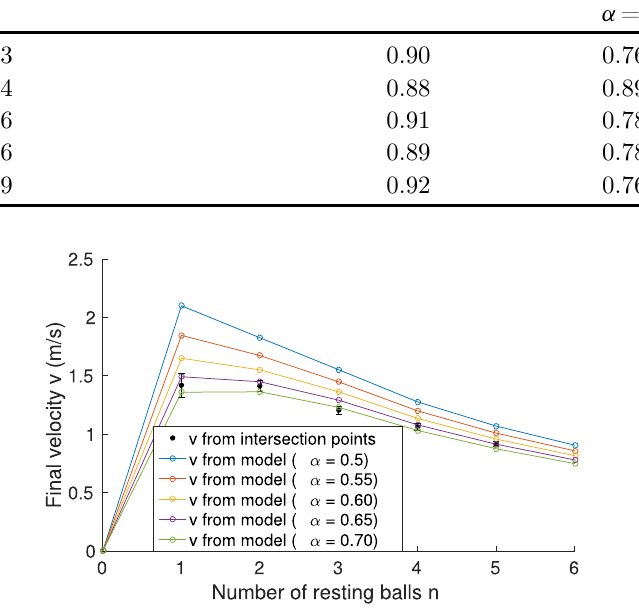
Table 2. COR values obtained from linearization of Figure 8, under the assumption e tot ¼ e 2 bm e n bb . Number of magnets